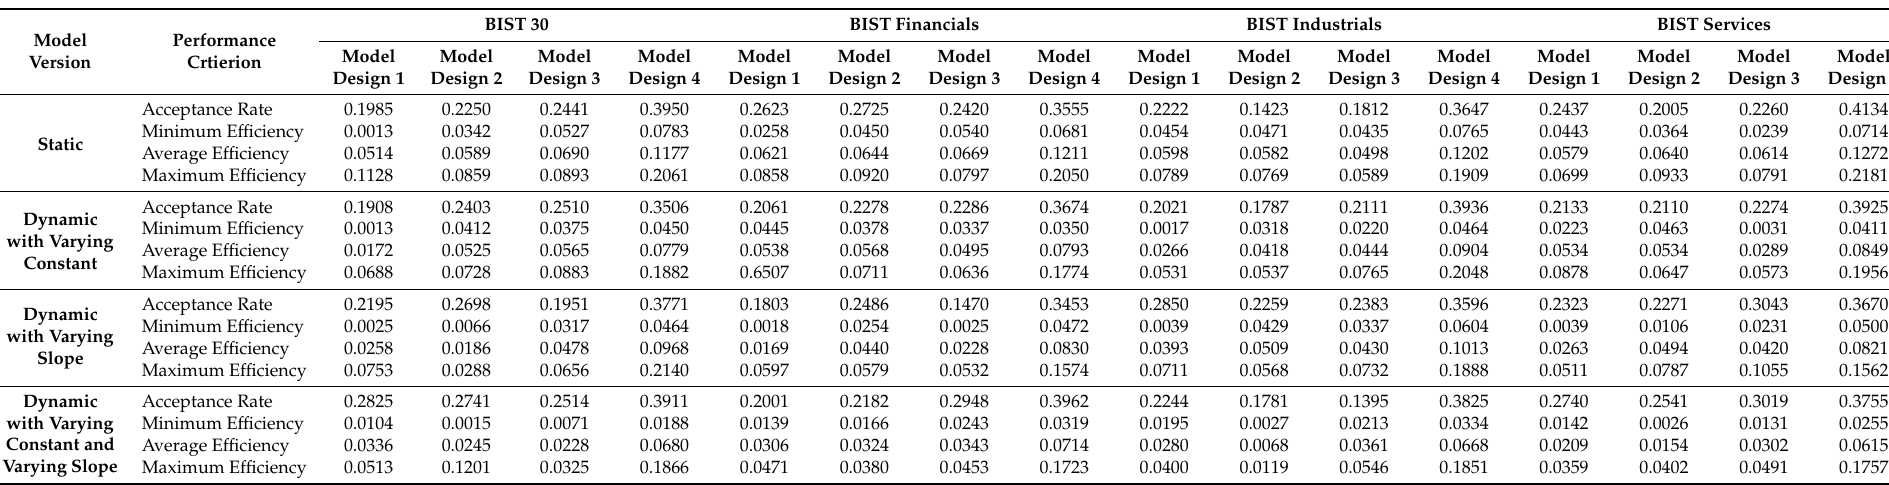
Table 6. Bayesian models: performance